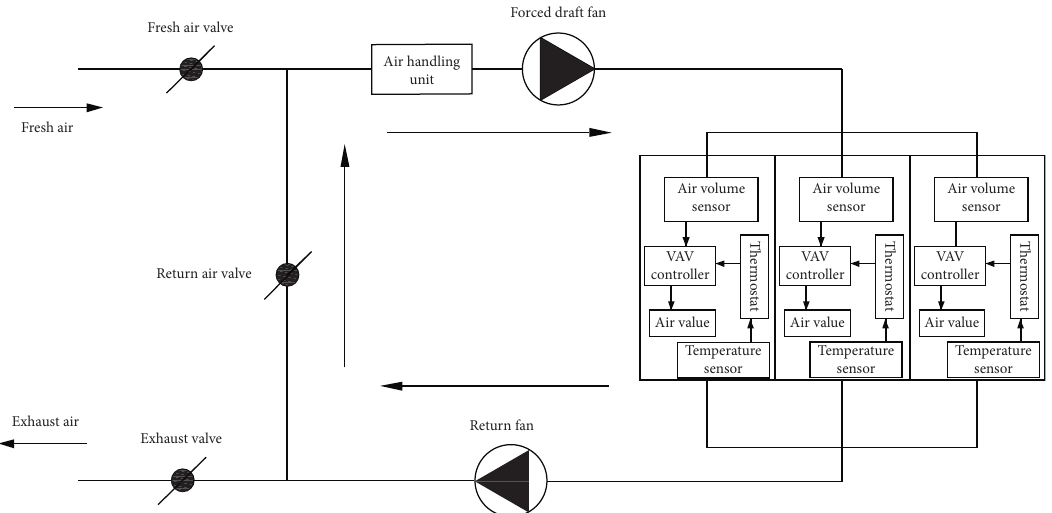
Figure 1: Structure diagram of the VAV air-conditioning system.